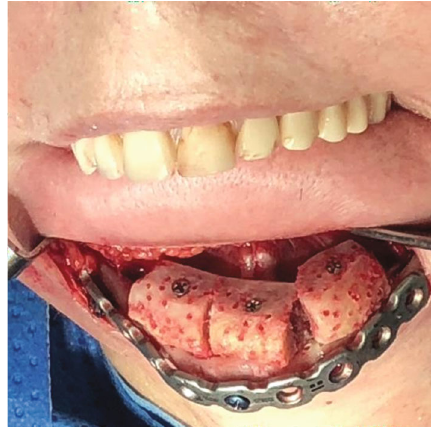
Figure 6: Postoperative healing of the extraoral access site (2